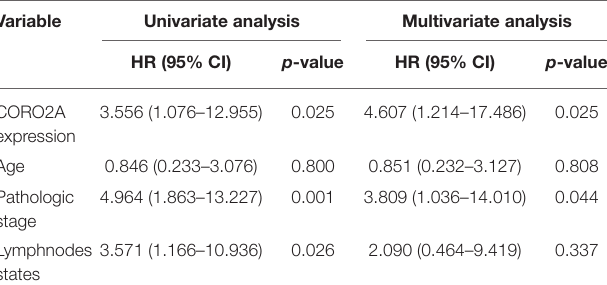
TABLE 3 | Cox proportional hazards regression analysis for RFS in TNBC patients.